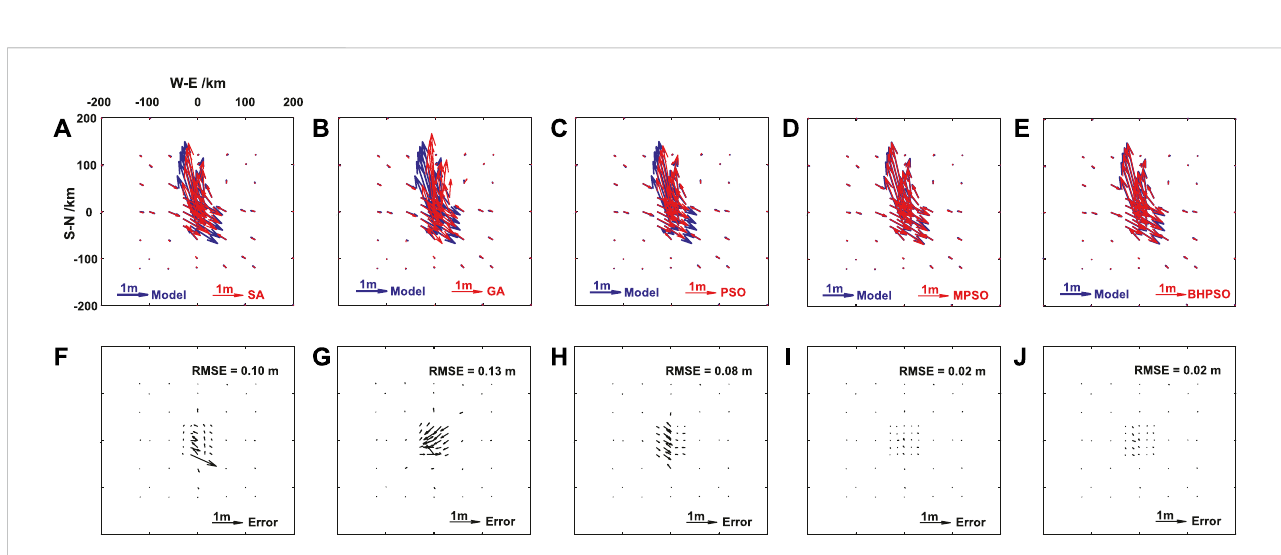
The comparisons of surface horizontal deformation (GPS data) of the Okada model results from the oblique-slip fault earthquake by using fault parameters given by the model and inversed from fi ve methods in Table 3. The surface horizontal deformation obtained by model and SA method (A) , model and GA method (B) , model and PSO method (C) , model and MPSO method (D) , and model and BHPSO method (E) . The residual of surface horizontal deformation between the results of model and SA method (F) , model and GA method (G) , model and PSO method (H) , model and MPSO method (I) , model and BHPSO method (J) . The blue arrows show the simulated surface horizontal deformation by the model in Table 3. The red arrows show the simulated surface horizontal deformation by using the fault parameters inversed from the fi ve methods. The black arrows show the fi tting